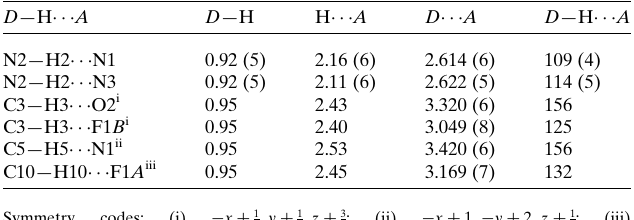
Table 3 Hydrogen-bond geometry (A˚ , (cid:2) ) for 3 .